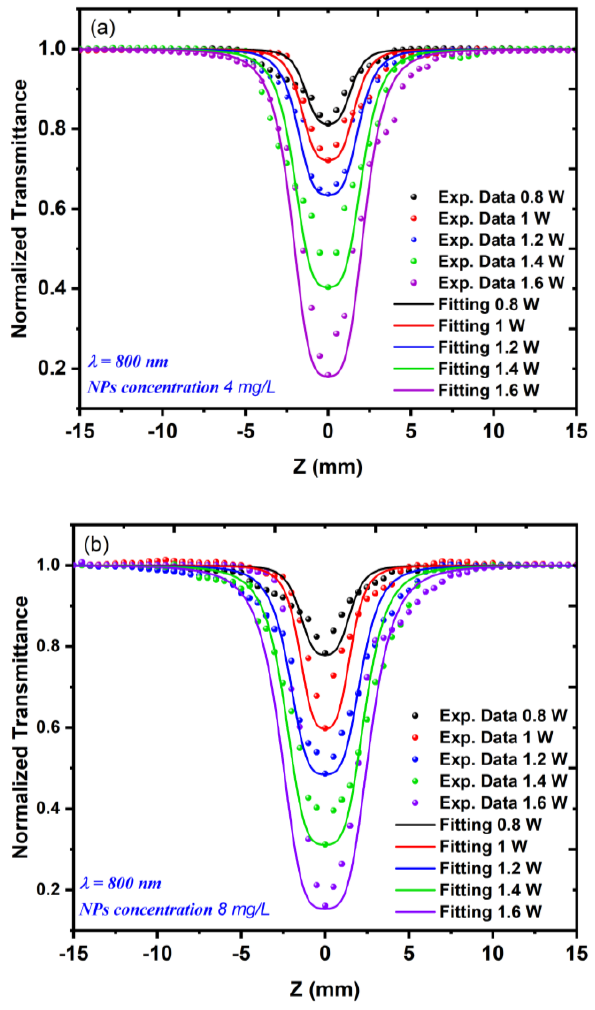
Figure 9. The OA z-scan measurements for the Au NP samples using different incident powers, which ranged from 0.8 to 1.6 W at a constant excitation wavelength of 800 nm: ( a ) a sample concentration of 4 mg/L; ( b ) a sample concentration of 8